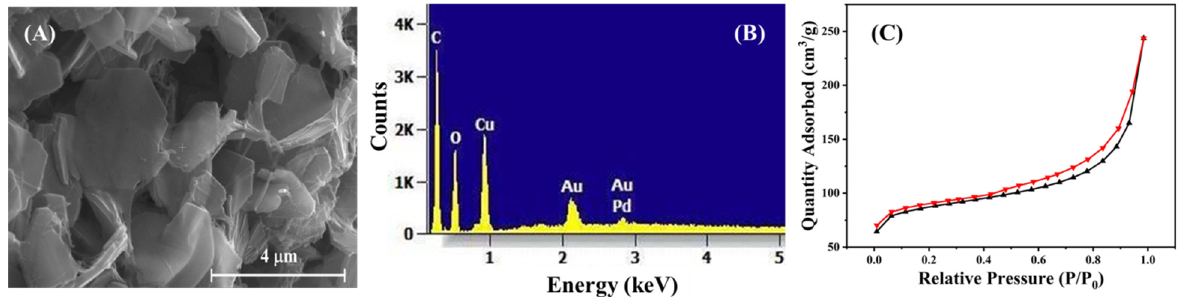
Figure 3. ( A ) SEM micrograph, ( B ) EDX elemental analysis pattern ( C ) N 2 -adsorption hysteresis of the as-prepared Cu-MOF